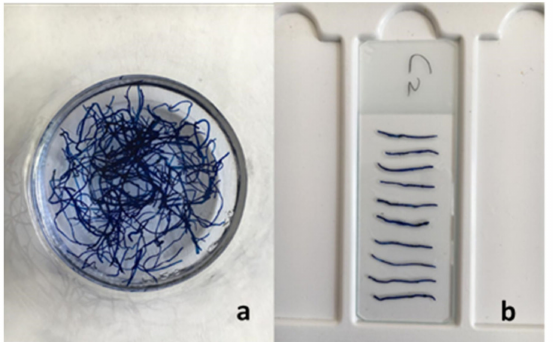
Figure 6. Roots staining for microscopic analysis: ( a ) roots stained with Trypan Blue stored at 4 ◦ C in dark; ( b ) 10 samples, 1 cm length on slide ready to be scanned under